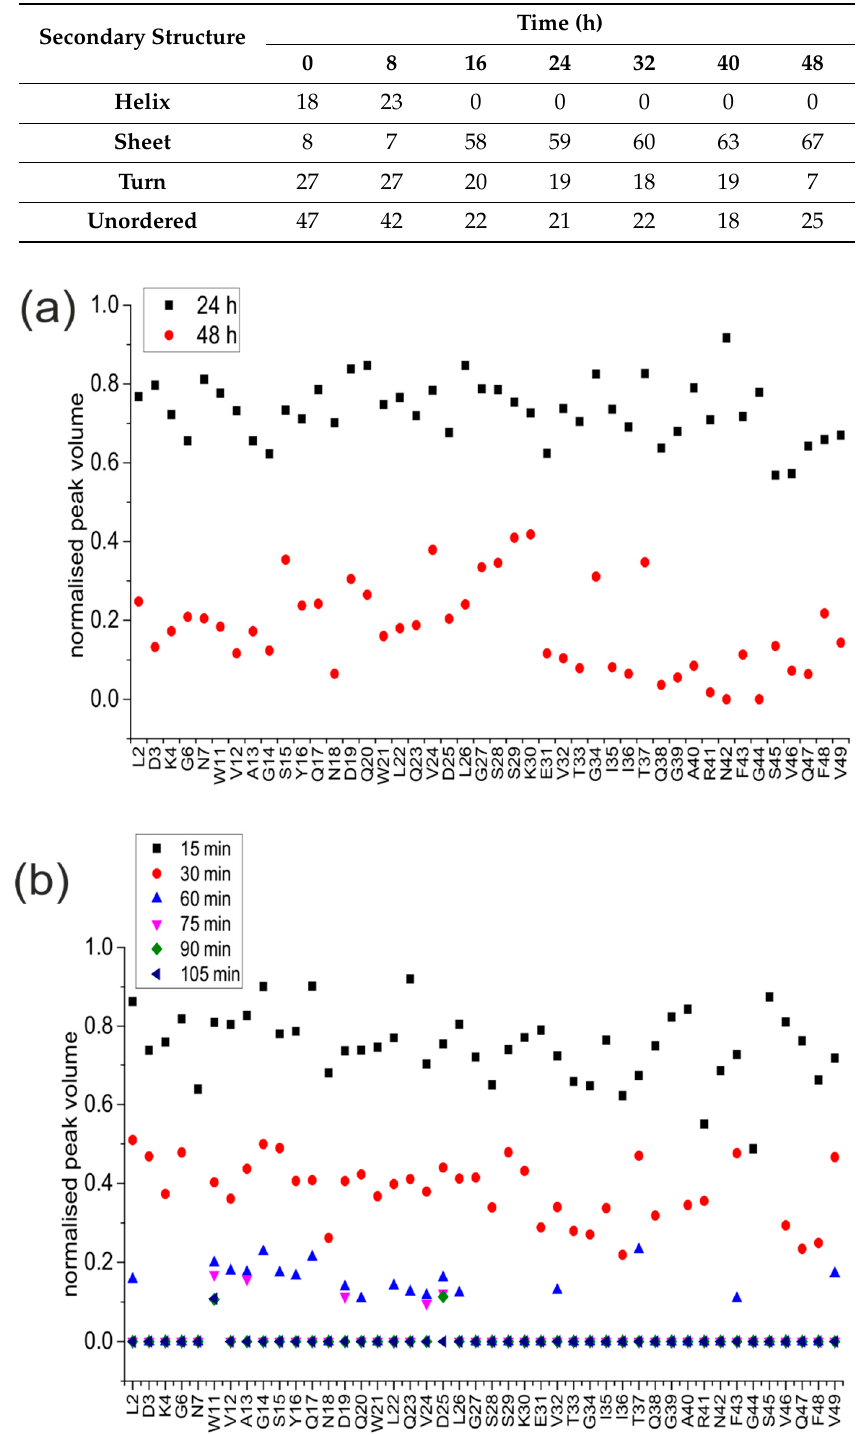
Figure 5. Site-specific NMR analysis. Normalised peak volume relative to starting volume for ( a ) quiescent incubation at 24 and 48 h, and ( b ) agitated incubation at 15, 30, 60, 75, 90 and 105 min.